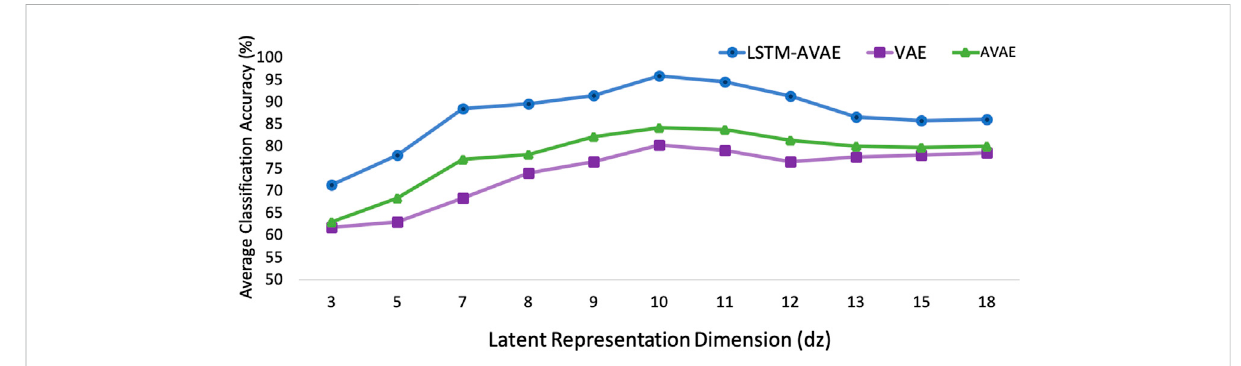
FIGURE 6 Classi fi cation accuracy results of the LSTM-AVAE and the VAE models ( λ =0.1) for different dimensions of the latent feature, d z , using MLP classi fi er.